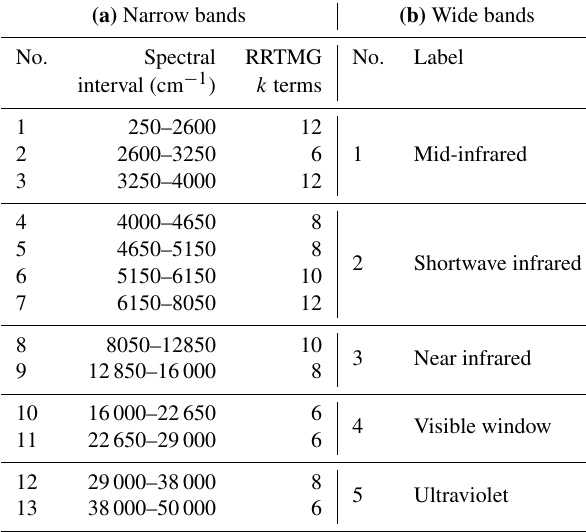
Table 6. As Table 5 but for the shortwave. (a) The narrow bands are as in RRTMG, except for band 7 which spans two RRTMG bands. The band boundaries are depicted in Fig.